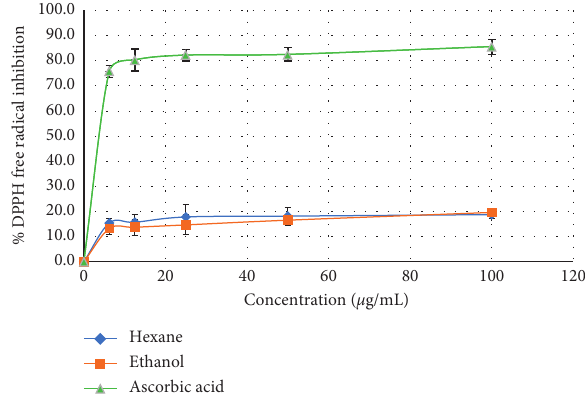
Figure 1: Percentage in vitro anti-inflammatory action of ethanol and hexane extracts of O. basilicum